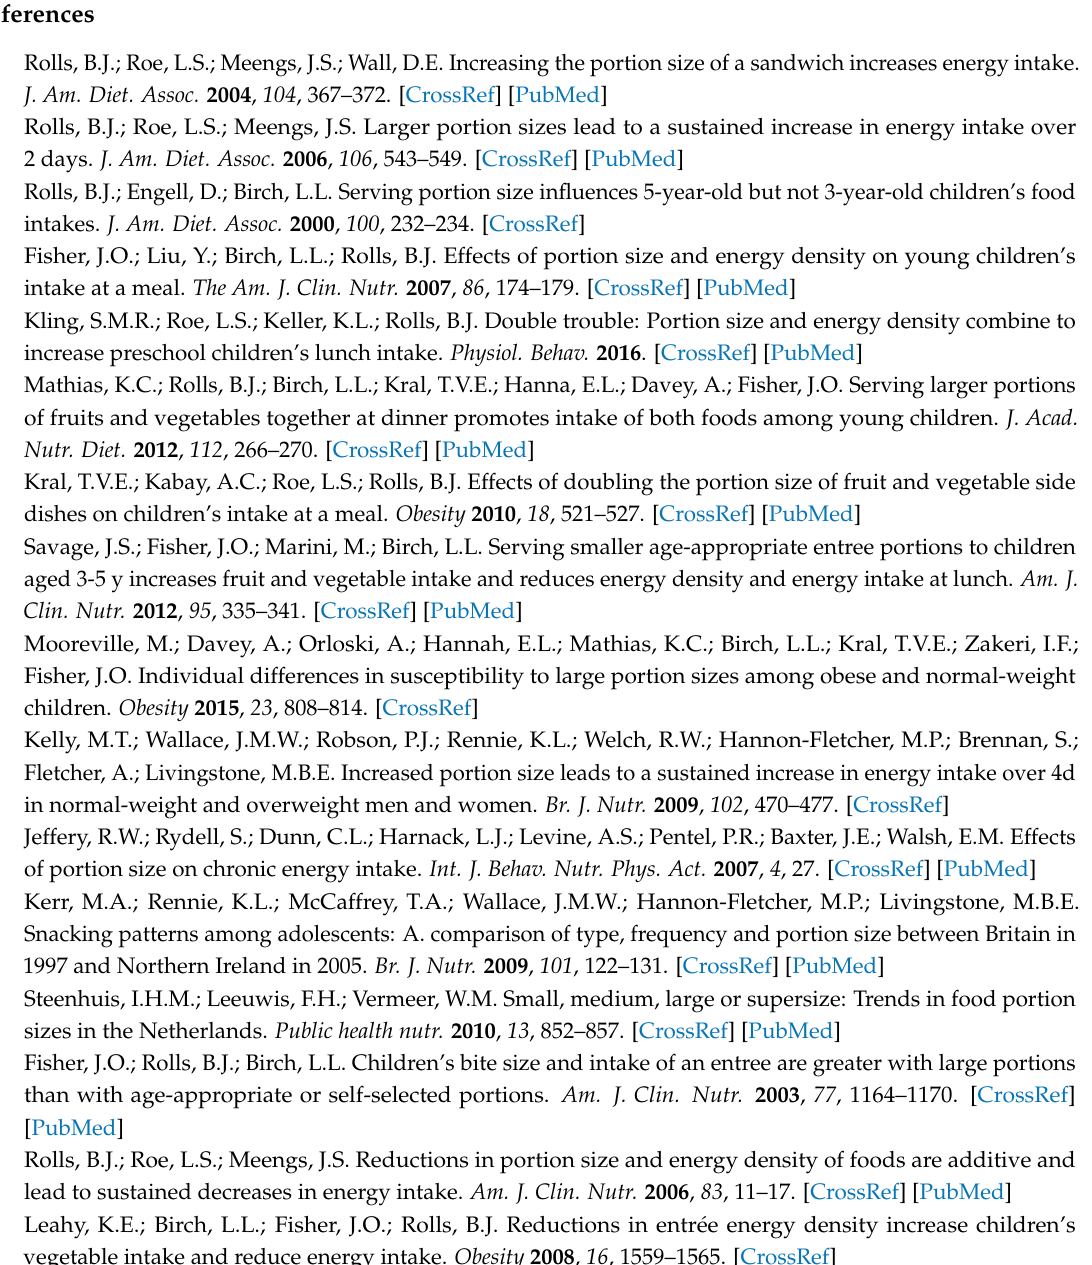
Table S1: Ratings for liking of sandwich and vegetables served to children as